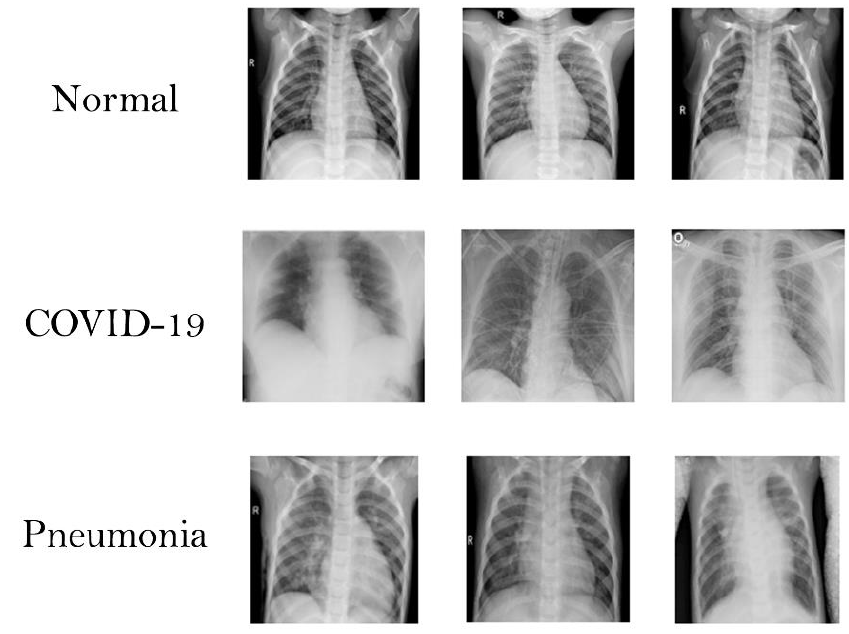
Figure 3. CXR image samples from the original dataset.